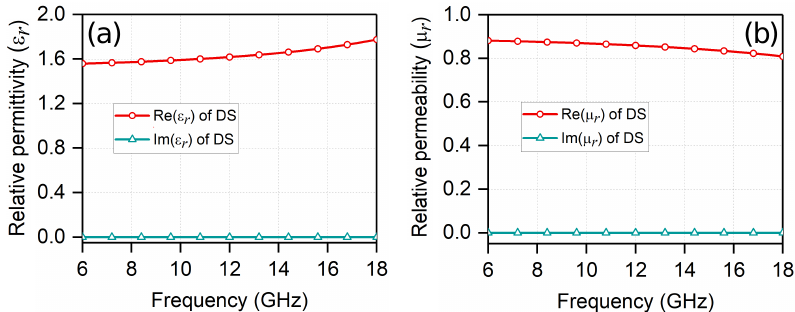
Figure 6. ( a ) Relative permittivity of the equivalent DS; ( b ) Relative permeability of the equivalent DS.